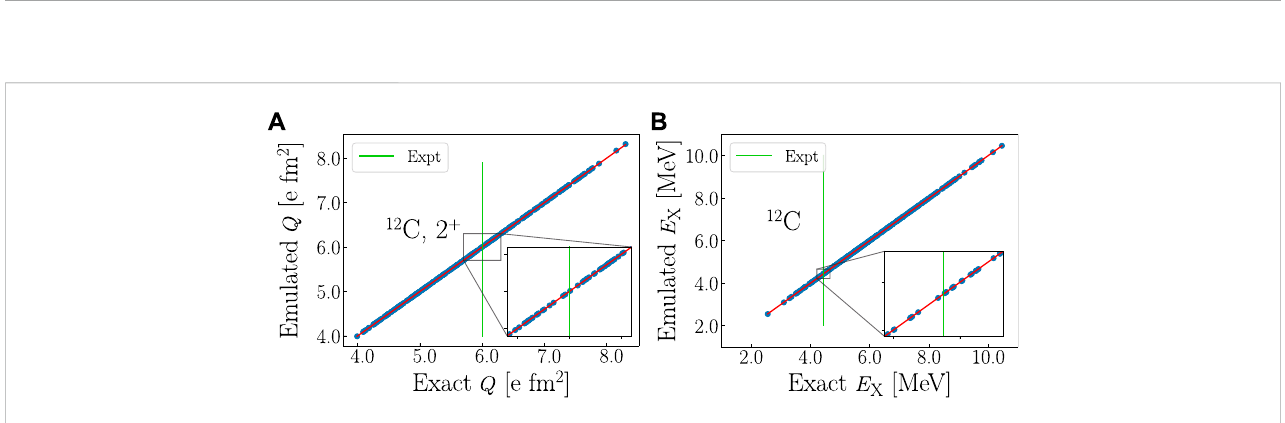
FIGURE 6 ThesameasinFigure5butfor (A) thequadrupolemoment Q and (B) theexcitationenergyofthe fi rst2 + statein 12 C,calculatedin6 3 SAmodelspacesand for Z Ω = 15 MeV. Insets show 5%-regions surrounding reported experimental data